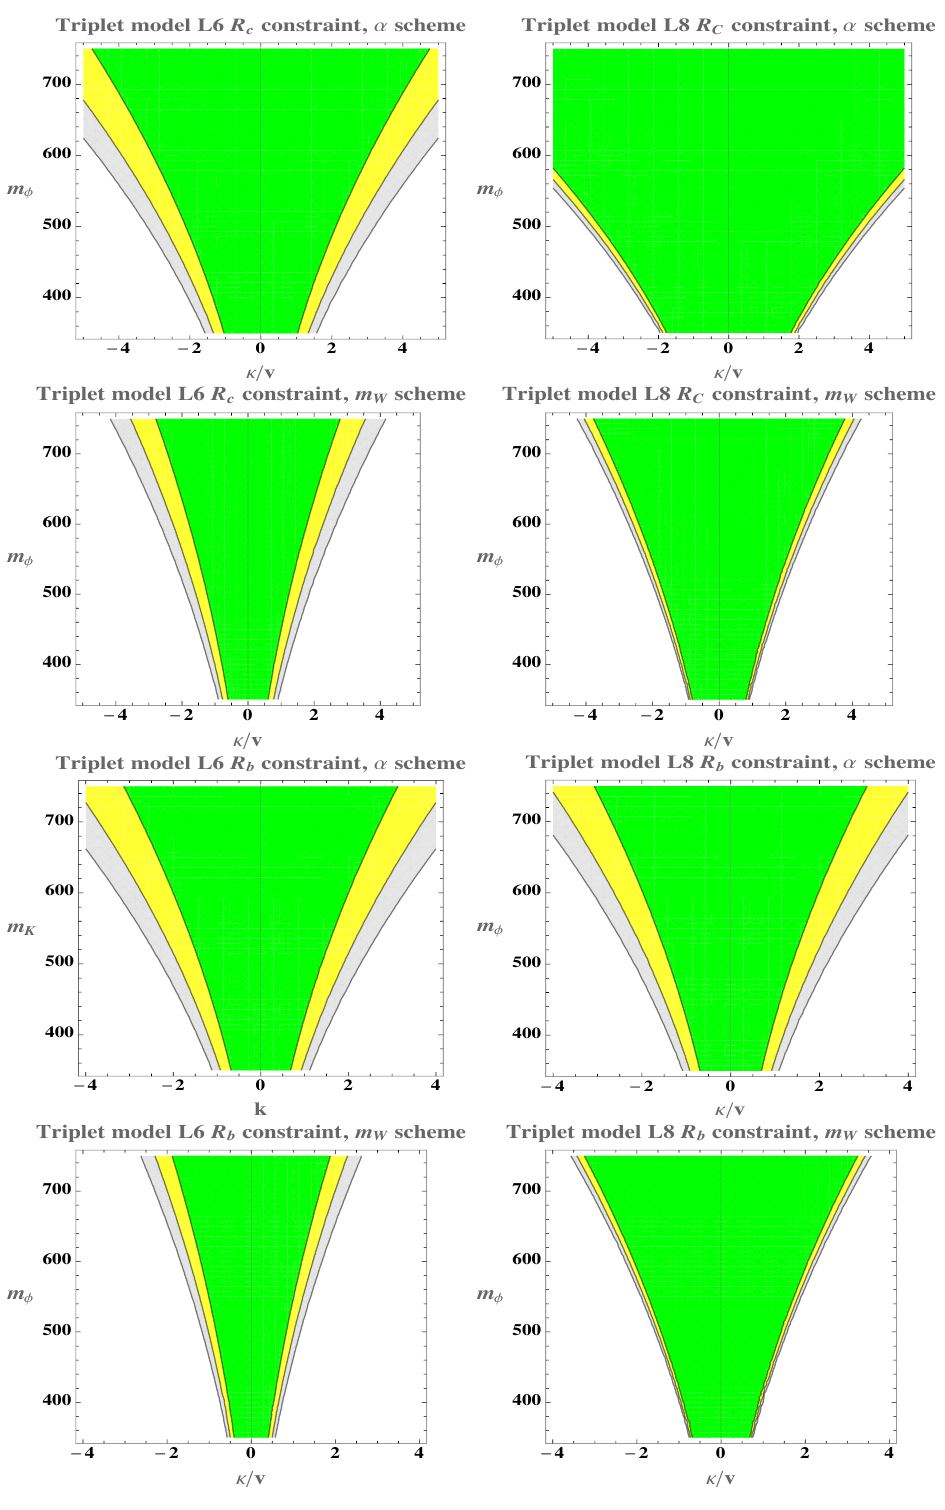
Figure 10 . Shown are the constraints on the model space from the R c and R b EWPD